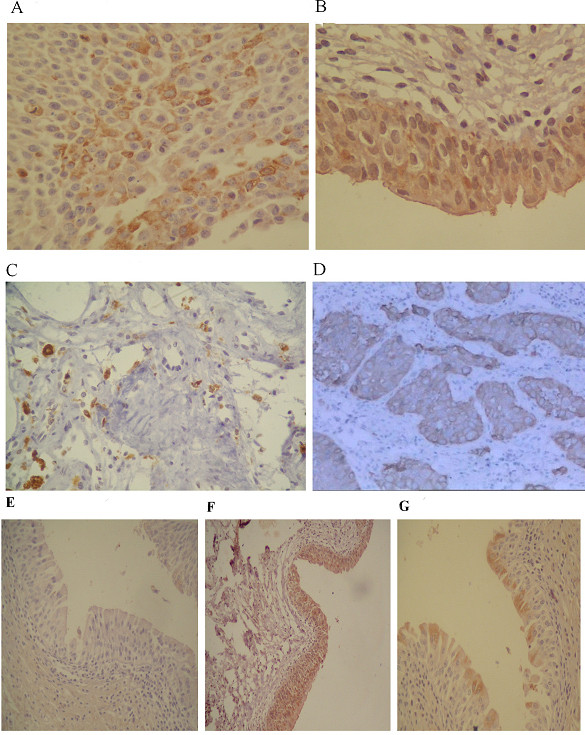
Expression of Slug, Twist, Snail and E-cadherin in human bladder cancer and bankground tissue was determined by immunohistochemistry. Staining of Snail(A), Slug(B), and Twist(C) was found in the cytoplasm as well as in the nucleus of tumor cells. Magnification, ×200. E-cadherin (D)expression was identified in the cell membrane and intensive in the cytoplasm. Magnification, ×200. No expression of Slug in bankground tissue(E), strong of Twist and Snail expression in bankground tissue (F-G).